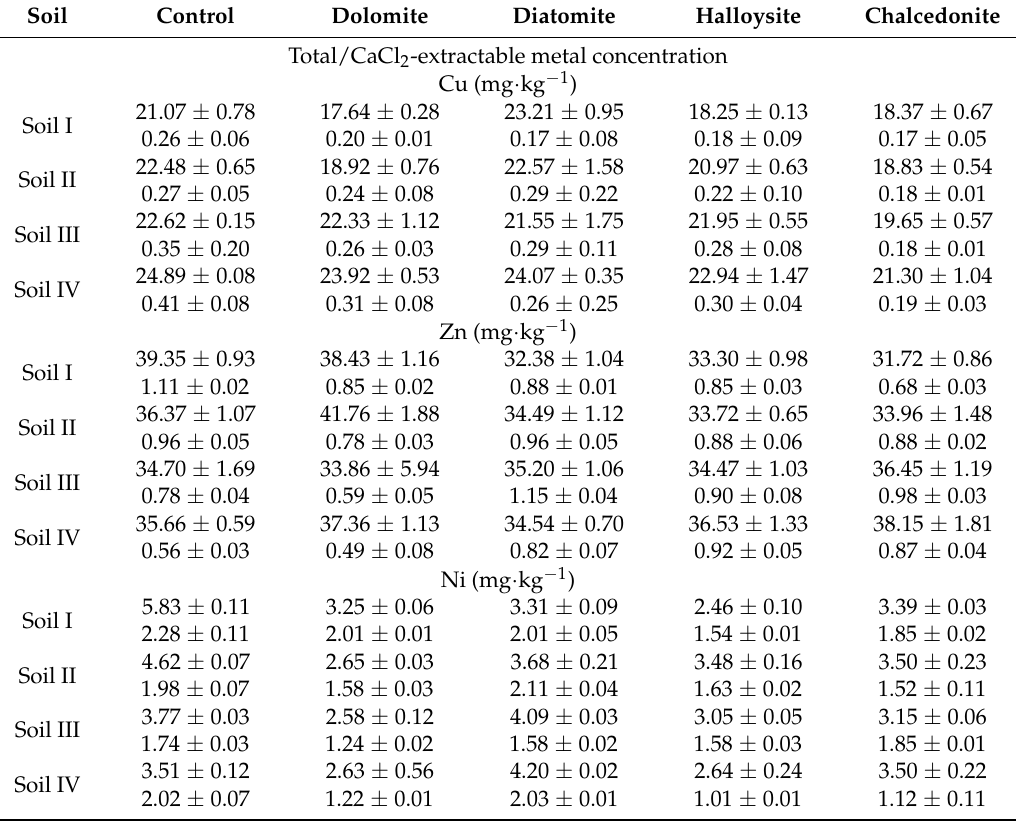
Table 3. Total and CaCl 2 -extractable Cu, Zn, and Ni concentrations in soils subjected to different treatments (mean ± SD, n =